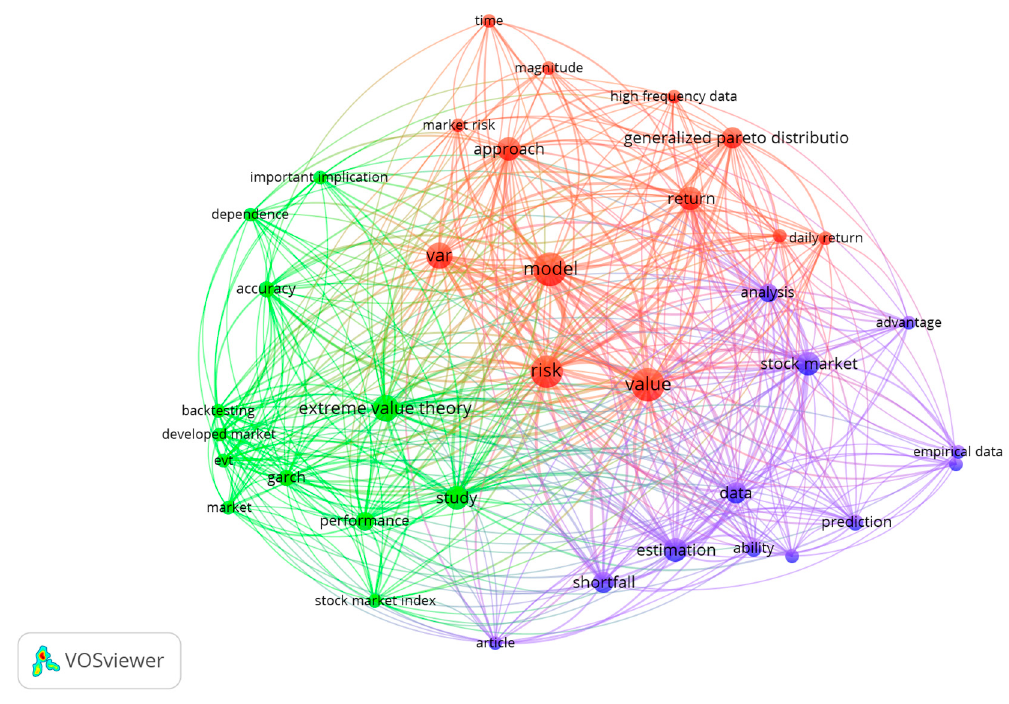
Figure 3. Visualization of bibliometric networks.